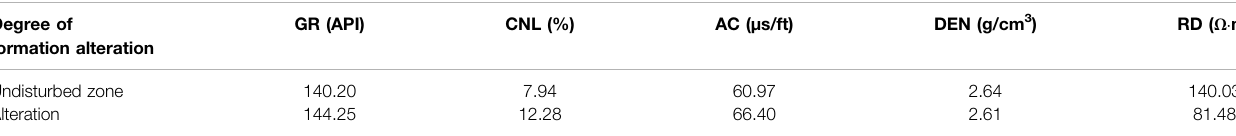
TABLE 1 | Average lower limit of logging curves in the buried hill formations of the Bozhong 19-6-A area. Degree of GR (API) CNL (%) AC ( μ s/ft) DEN (g/cm 3 ) RD ( Ω · m) formation alteration Undisturbed